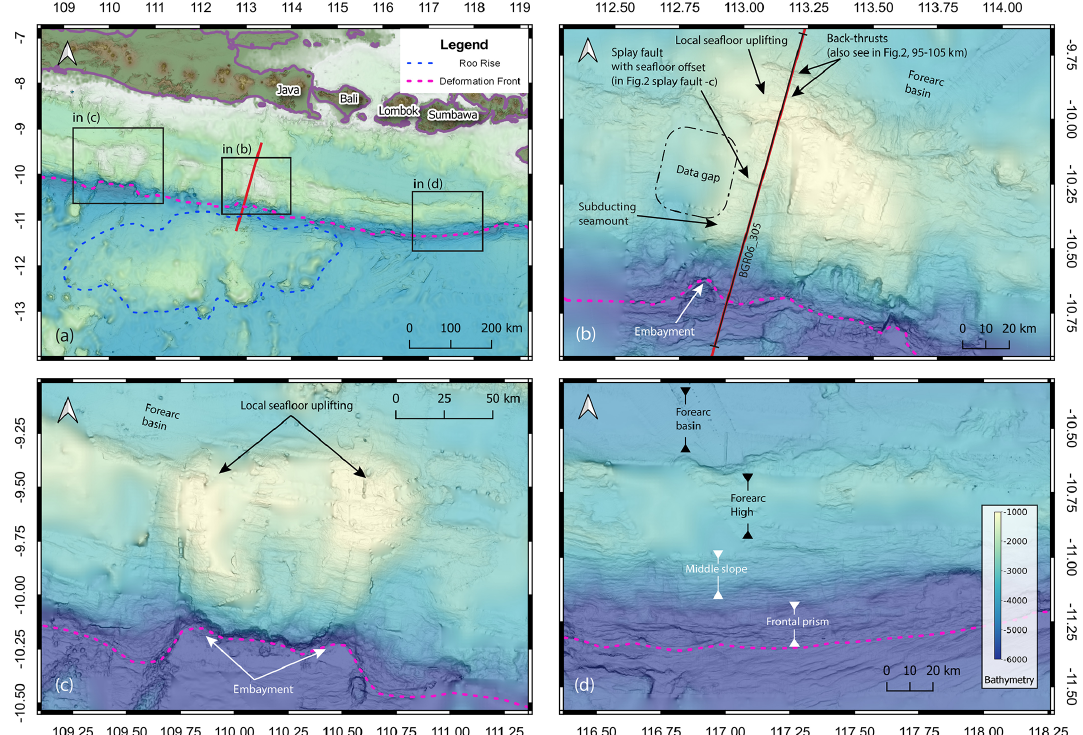
Figure 4. Global satellite bathymetry merged with ship-based multibeam data along the Java margin and Lesser Sunda islands (Bali, Lombok, and Sumbawa). Black squares indicate locations of close-up views in (b–d) ; red line indicates location of MCS profile BGR06_305 discussed in this study. (a) Bathymetry from 108.5 to 119.5 ◦ E. The accretionary wedge from 109 to 115 ◦ E is deformed and disturbed by the subducting seamounts and ridges associated with the Roo Rise. In comparison, the accretionary wedge from 115 to 119 ◦ E forms a more homogeneous structure compared to the western area. (b) A close-up view of the bathymetry in the vicinity of MCS profile BGR06_305. An embayment of the deformation front is observed at the trailing edge of the subducting seamount. A thrust fault offsets the seafloor landward of the seamount. The forearc high and the southern margin of the forearc basin experience uplift to a water depth less than 1000m. (c) A close view of the seafloor bathymetry off central Java. The accretionary wedge and forearc high are uplifted to shallow water depth of ∼ 750m, and the deformation front is characterized by a large embayment at the trench. (d) The seafloor bathymetry map off the coast of Lombok–Sumbawa reveals a much more homogenous accretionary wedge compared to its western